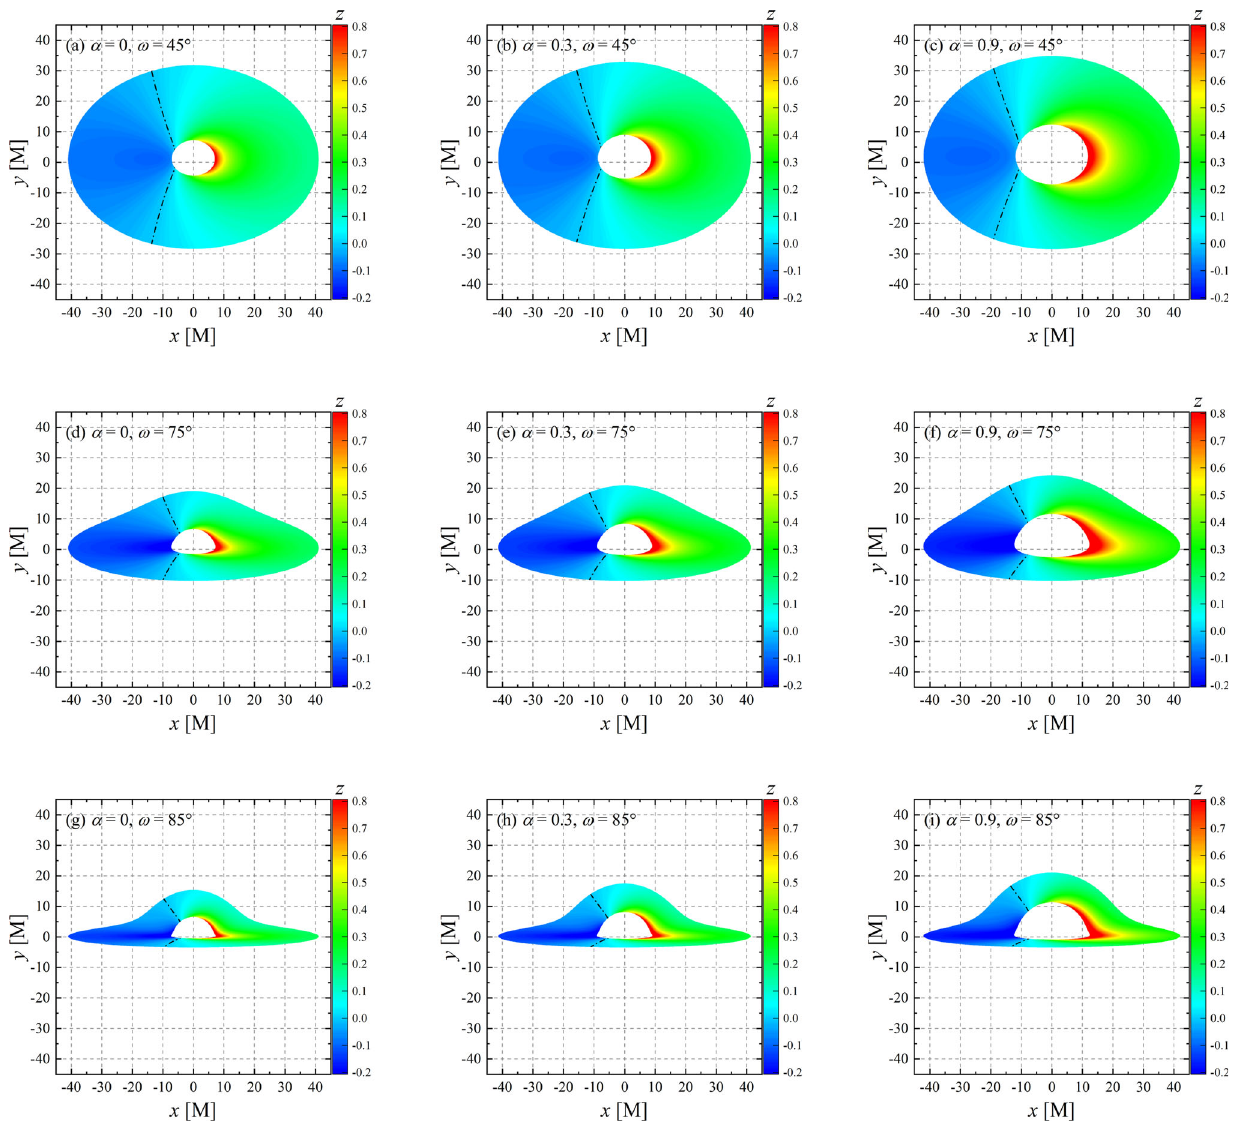
resented by blue. The black dashed line denotes the contour curve of z = 0. Here, the inner and outer boundaries of the accretion disk are the stable circular orbits with radii r = r ms and r = 40,